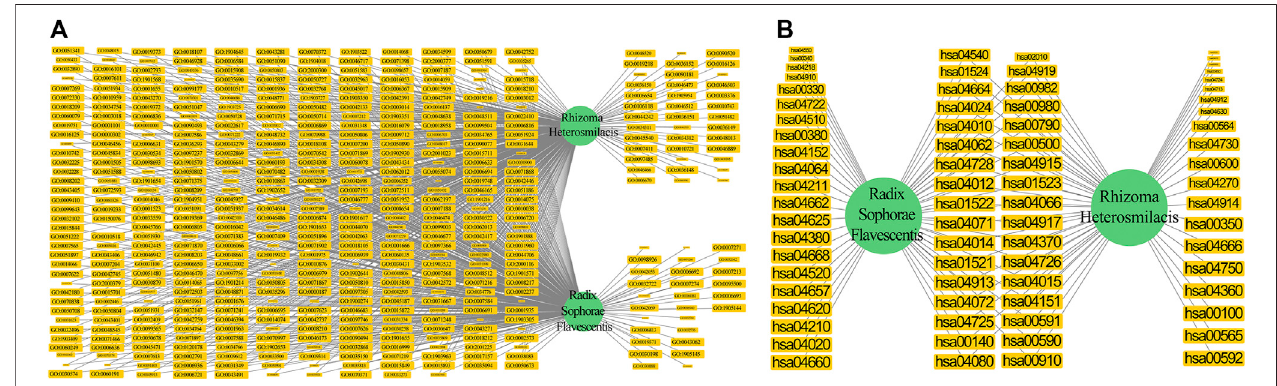
FIGURE5| Componentswererepresentedingreen.TheGO-BPtermsandpathwayswererepresentedinyellow.ThesizeofthepathwayswasrelatedtotheFDR adjust p value. The lower FDR adjust p value represented the larger size. (A) The network of selected GO-BP terms based on the fi rst quartile value of all GO-BP terms FDR adjust p value. The left of the network was the commonly enriched GO-BP terms. The upper right of the network was the unique GO-BP terms of Rhizoma Heterosmilacis . The lower right of the network was the unique GO-BP terms of Radix Sophorae Flavescentis . (B) The network of pathways between Rhizoma Heterosmilacis and RadixSophoraeFlavescentis .Thecenterofthenetworkwasthecommonlyenrichedpathways.Therightofthenetworkwastheuniquepathwaysof Rhizoma Heterosmilacis . The left of the network was the unique pathways of Radix Sophorae Flavescentis .